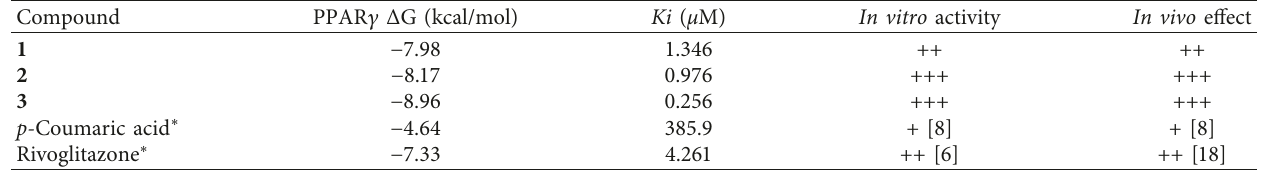
Table 1: Molecular docking binding energies, calculated affinities, and qualitative pharmacological activities of compounds 1–3 . Compound